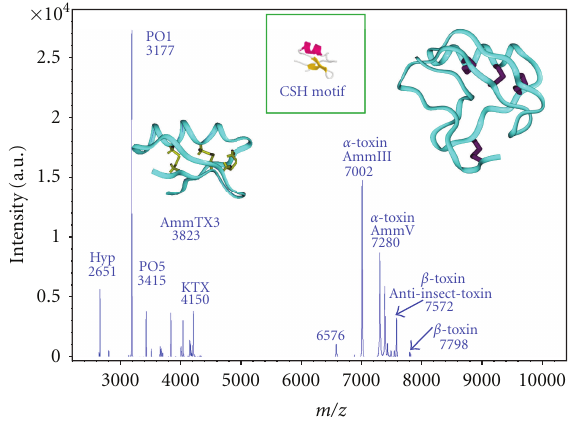
Figure 1: MALDI-TOF mass spectra of pool venom manually extracted from Androctonus mauretanicus mauretanicus . K + channel blockers and voltage-gated Na + channels modulators are